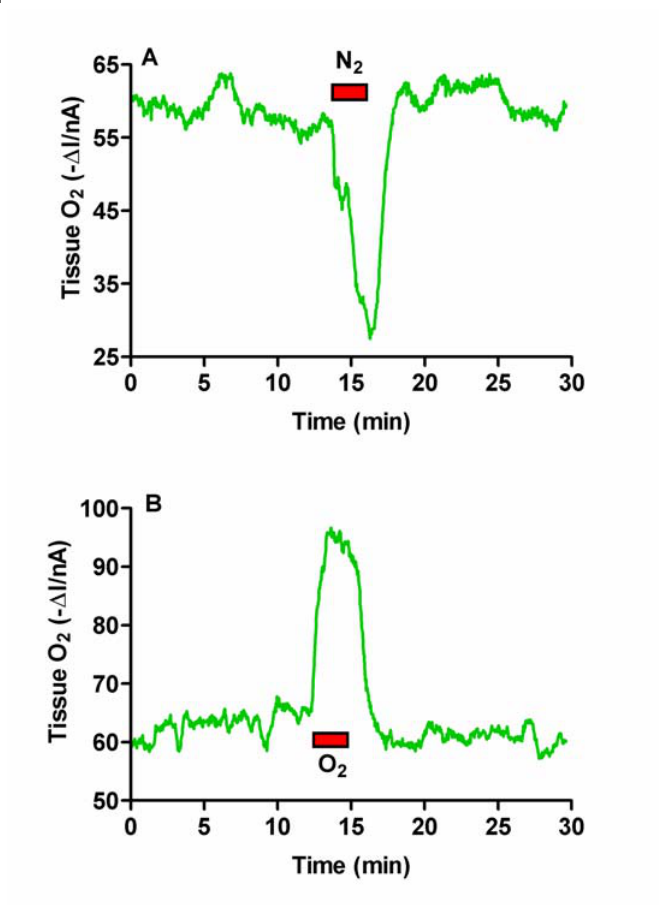
Figure 1. Typical raw data examples of the effects of mild hypoxia ( A ) and hyperoxia ( B ) on brain tissue O levels monitored using a carbon paste electrode implanted in the striatum of a freely-moving 2